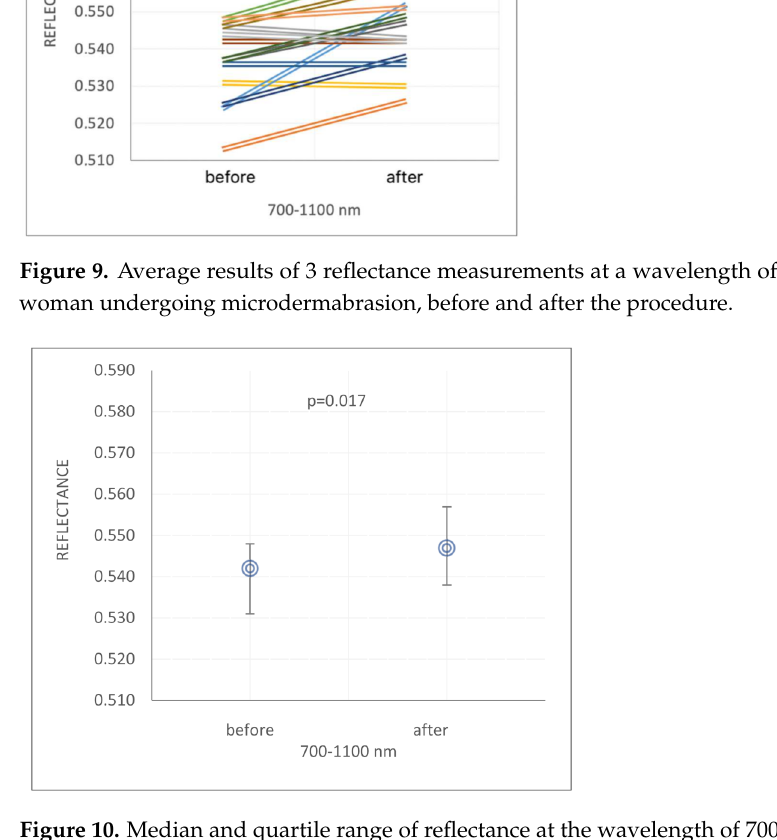
Figure 10. Median and quartile range of reflectance at the wavelength of 700–1100 nm in the group of women undergoing microdermabrasion, before and after the